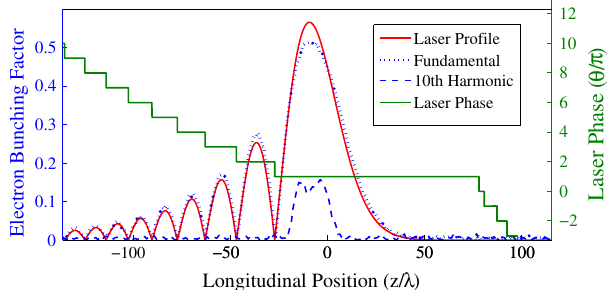
FIG. 8. Slice bunching factor [Eq. (6)] as a function of position for the fundamental and 10th harmonic. Third order spectral phase on the seed laser produces side pulses on the time-domain E field (solid red line). The temporal phase (solid green line) is flat within each pulse, but jumps by (cid:2) between pulses. The 10th harmonic bunching factor (dashed blue line) exists only in the center of the largest pulse, and consequently does not pick up the third order